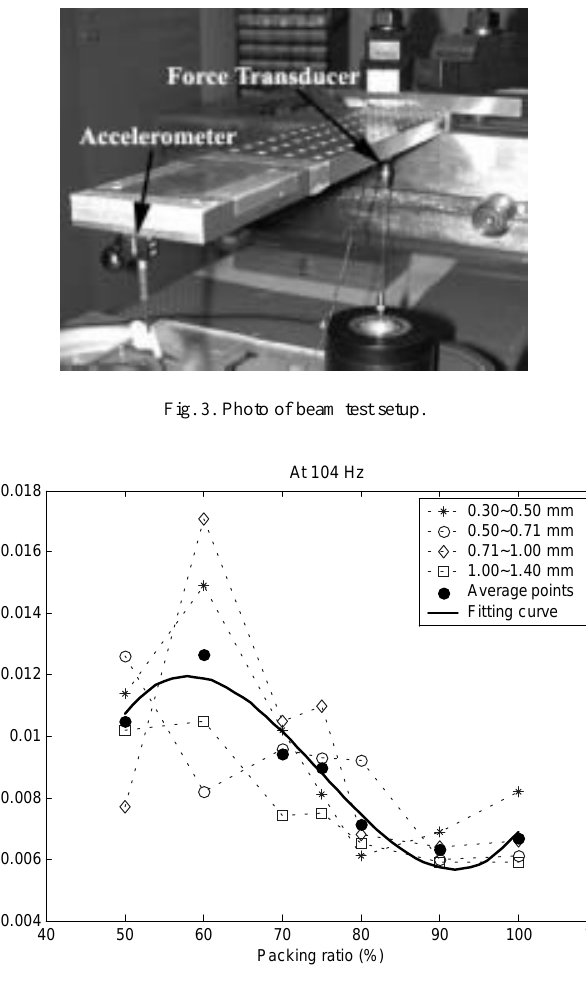
Fig. 4. Damping ratio vs. packing ratio for different particle diameters at 104